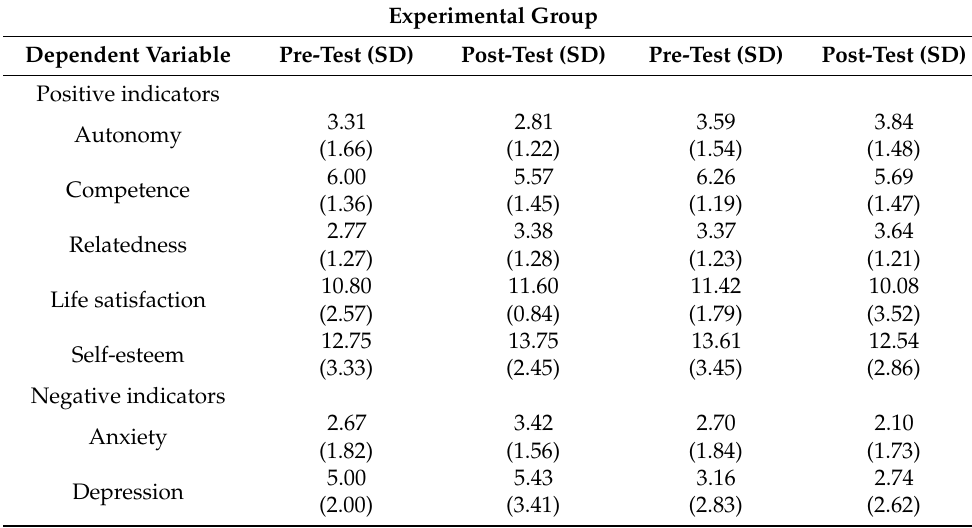
Table 2. Means and standard deviations for positive and negative indicators of mental